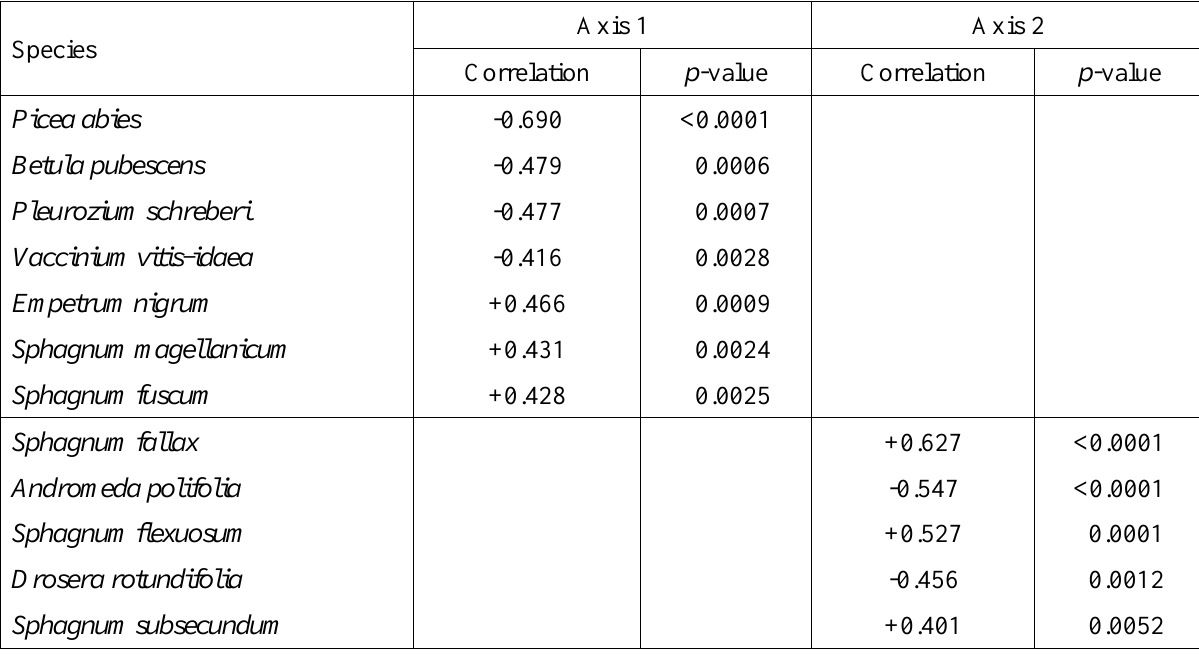
Table 3. Descending-ordered list of species best correlated with the first two partial PCoA axes. Only correlations over 0.4 in absolute values are